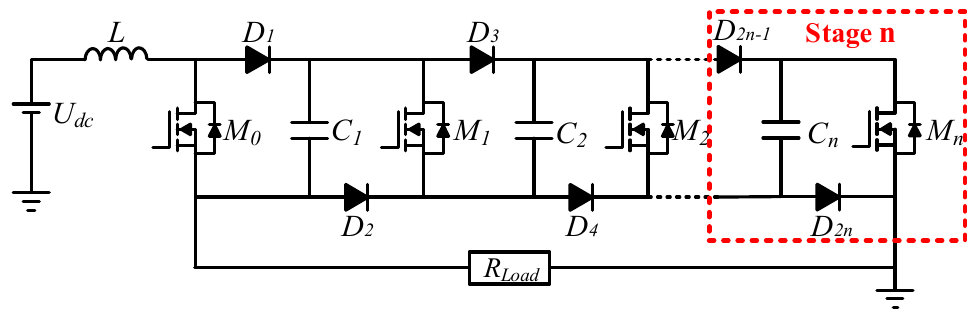
Figure 1. Proposed Boost-Marx pulse generator.